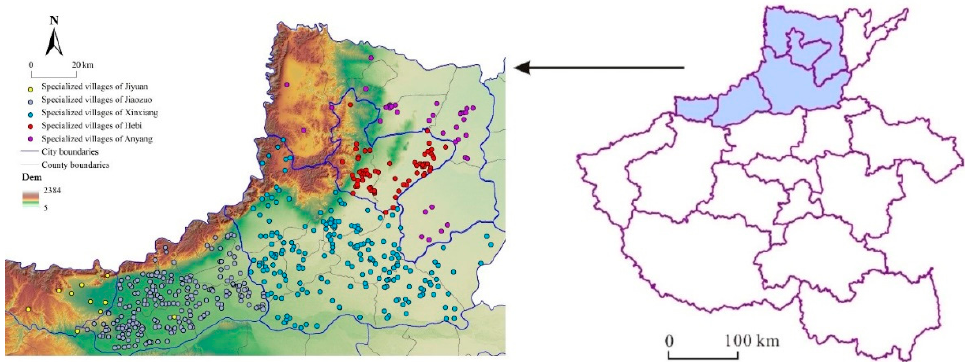
Figure 1. Distribution of specialized villages at the foot of Taihang Mountains. Note: In China, administrative divisions are divided into five levels: province, city, county, town, village. Among them, the administrative scope of the city is larger than that of the county.